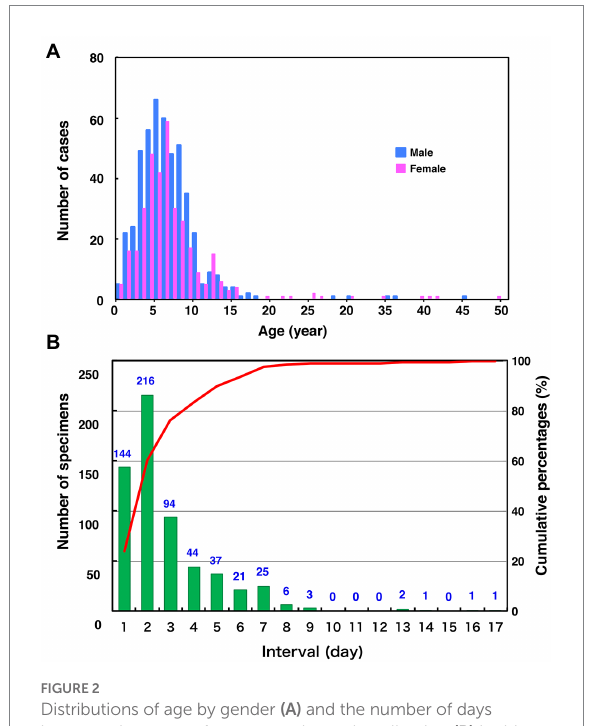
FIGURE 2 Distributions of age by gender (A) and the number of days between the onset of mumps and sample collection (B) in this study. (A) Blue and the red bars indicate the number of male and female mumps cases, respectively. (B) The green bars and the red line show clinical sample numbers and cumulative percentage by interval days between the onset of mumps and sample collection,